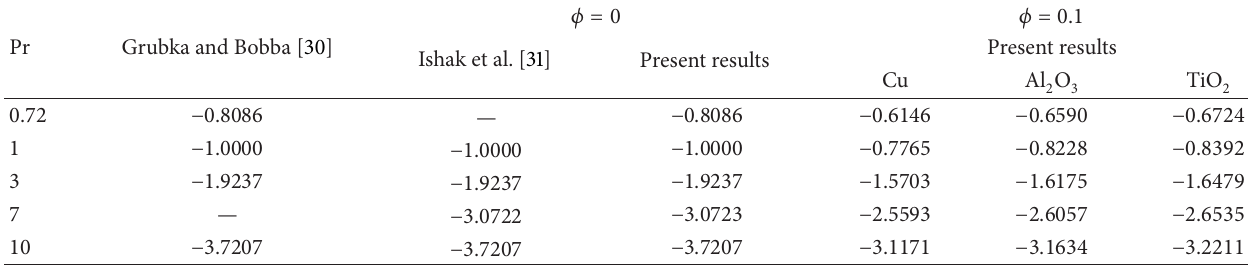
Table 1: Surface temperature gradient 𝜃 󸀠 (0) for 𝜆 = 0 , 𝜙 = 0 , and 𝜙 = 0.1 . 𝜙 = 0